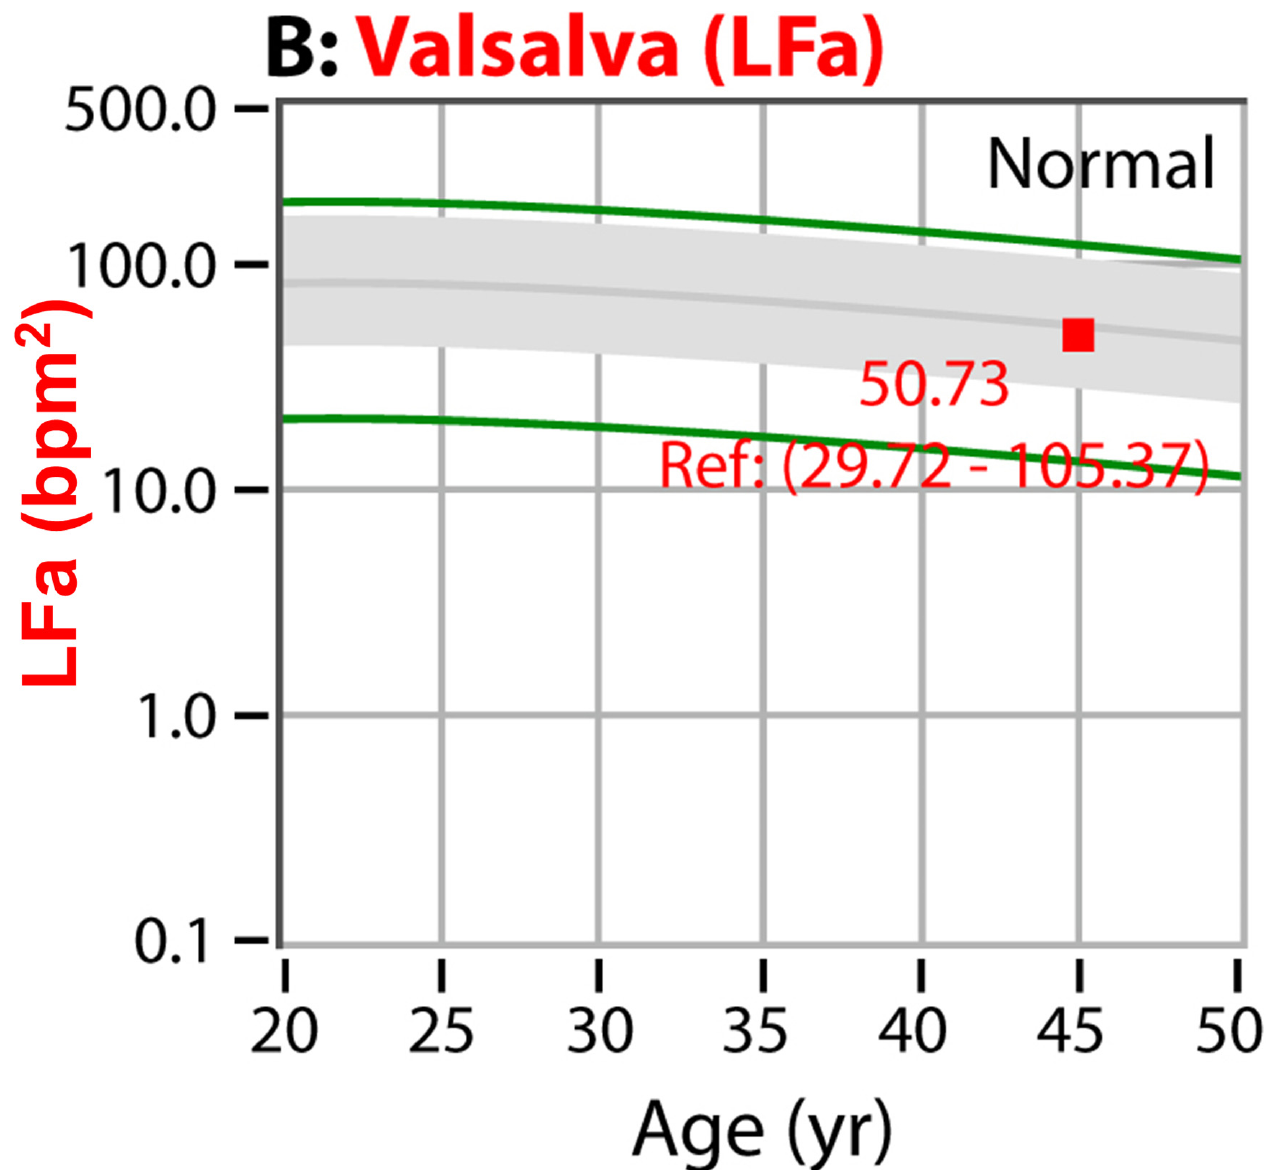
Figure 2. “Normal Response to Valsalva.” The Valsalva challenge is a series of short ( ≤ 15 s) Valsalva maneuvers. Short Valsalva maneuvers are well-known and potent sympathetic stimuli. The figure displays a Valsalva response plot demonstrating a normal sympathetic response for a 45 y/o patient. The gray area indicates the normal region [18]. These data are both age- and baseline-adjusted [16]. The area between the green lines and the gray indicates borderline normal responses. Borderline low to low Valsalva responses are some of the earliest signs of PAN and risk of sudomotor or SFD.